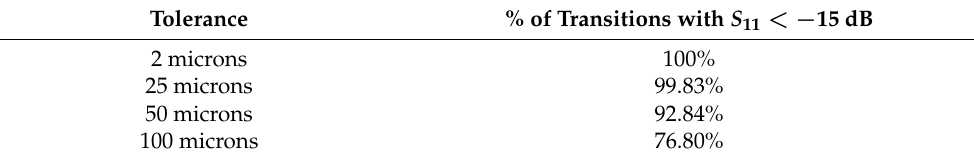
Table 3. Results of the yield